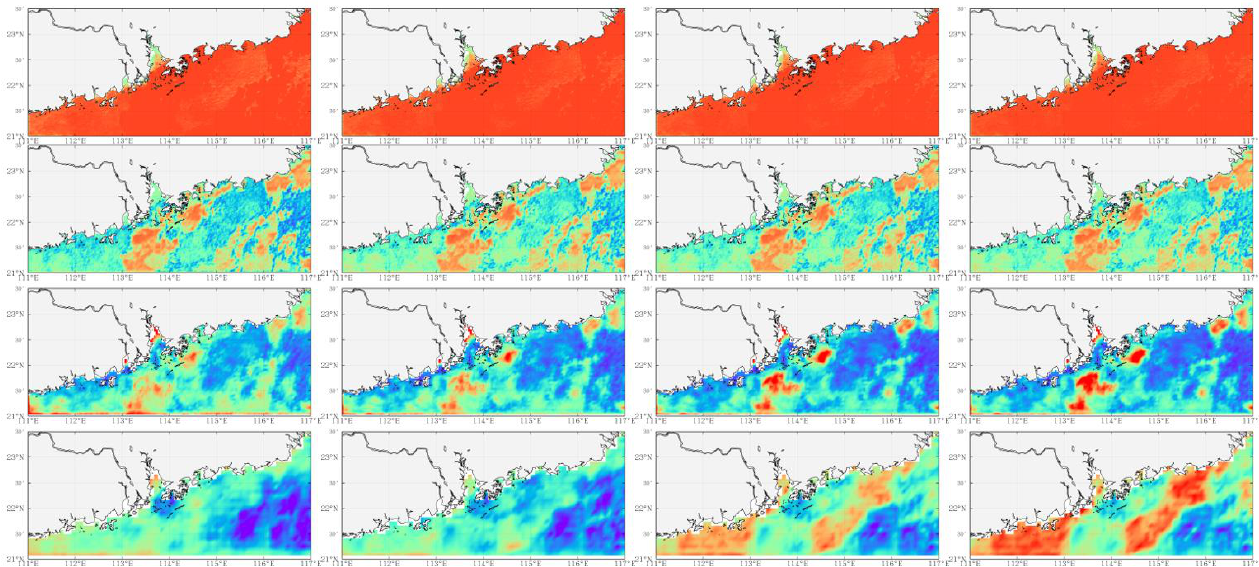
Figure 11. Example of feature maps given an input sample. Top to bottom row shows the AG maps of the four attention layers. Left to right column shows the AG maps across different training epochs (6, 8, 10, 100).